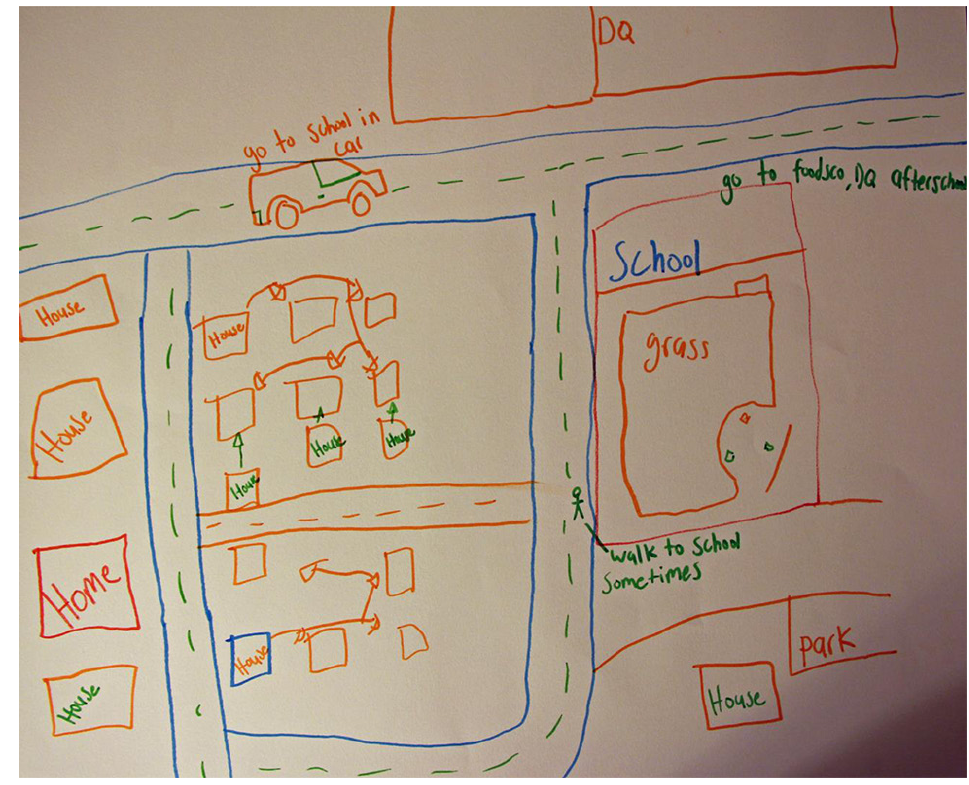
Figure 2 Sample map from focus